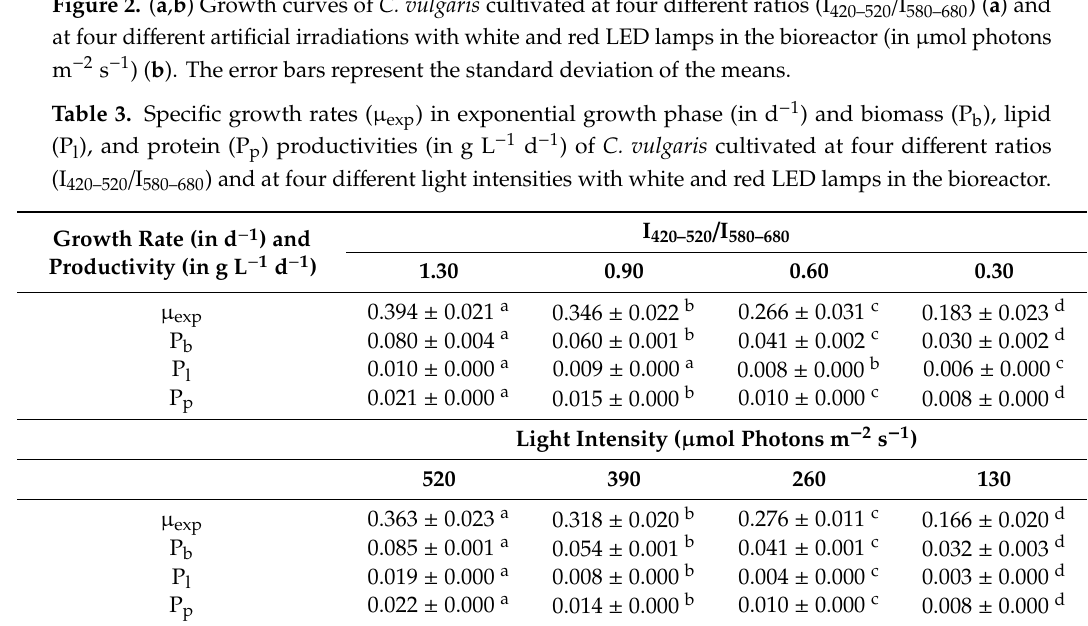
Values represent averages ± std. deviation ( n = 9). Values in the same column followed by different superscript indicate statistically significant difference ( p < 0.05).